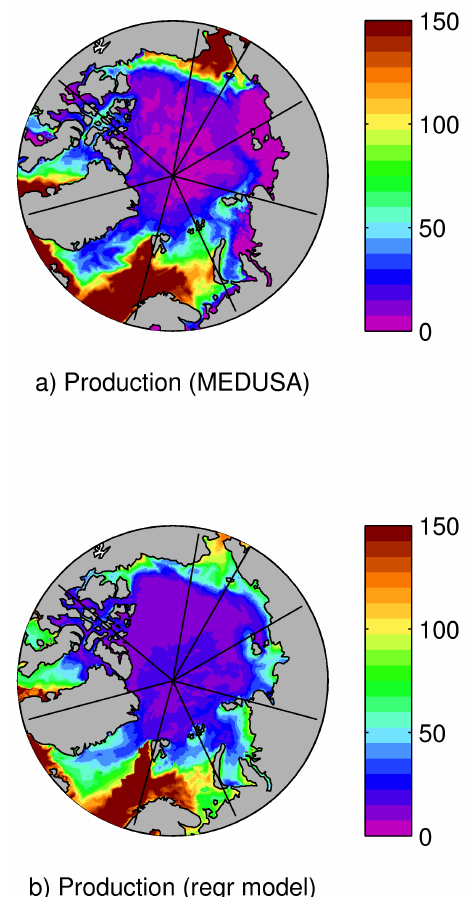
Fig. 10. Primary production (gCm − 2 yr − 1 ) obtained from (a) the MEDUSA ecosystem model, (b) the multiple linear regression model with summer short wave radiation and maximum winter mix- ing as predictors.